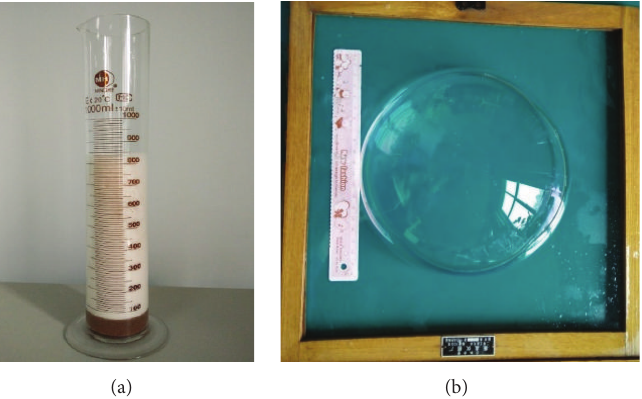
Figure 1: The scheme of the experiment.